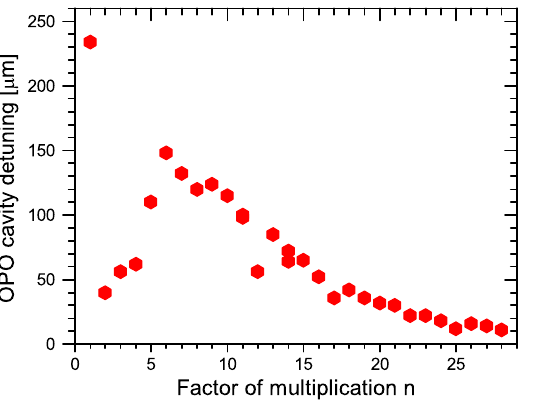
Figure 16. Dependence of resonator length detuning enabling the generation on the factor of multi- plication n in the ring